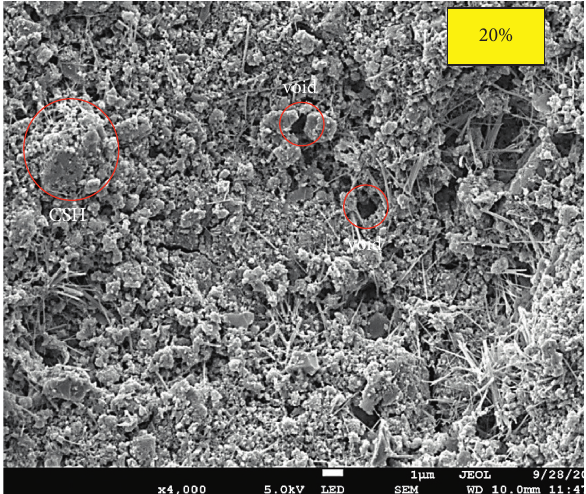
Figure 25: Microstructure of POC LWAC containing 20% spent garnet after exposure to hydrochloric solution at